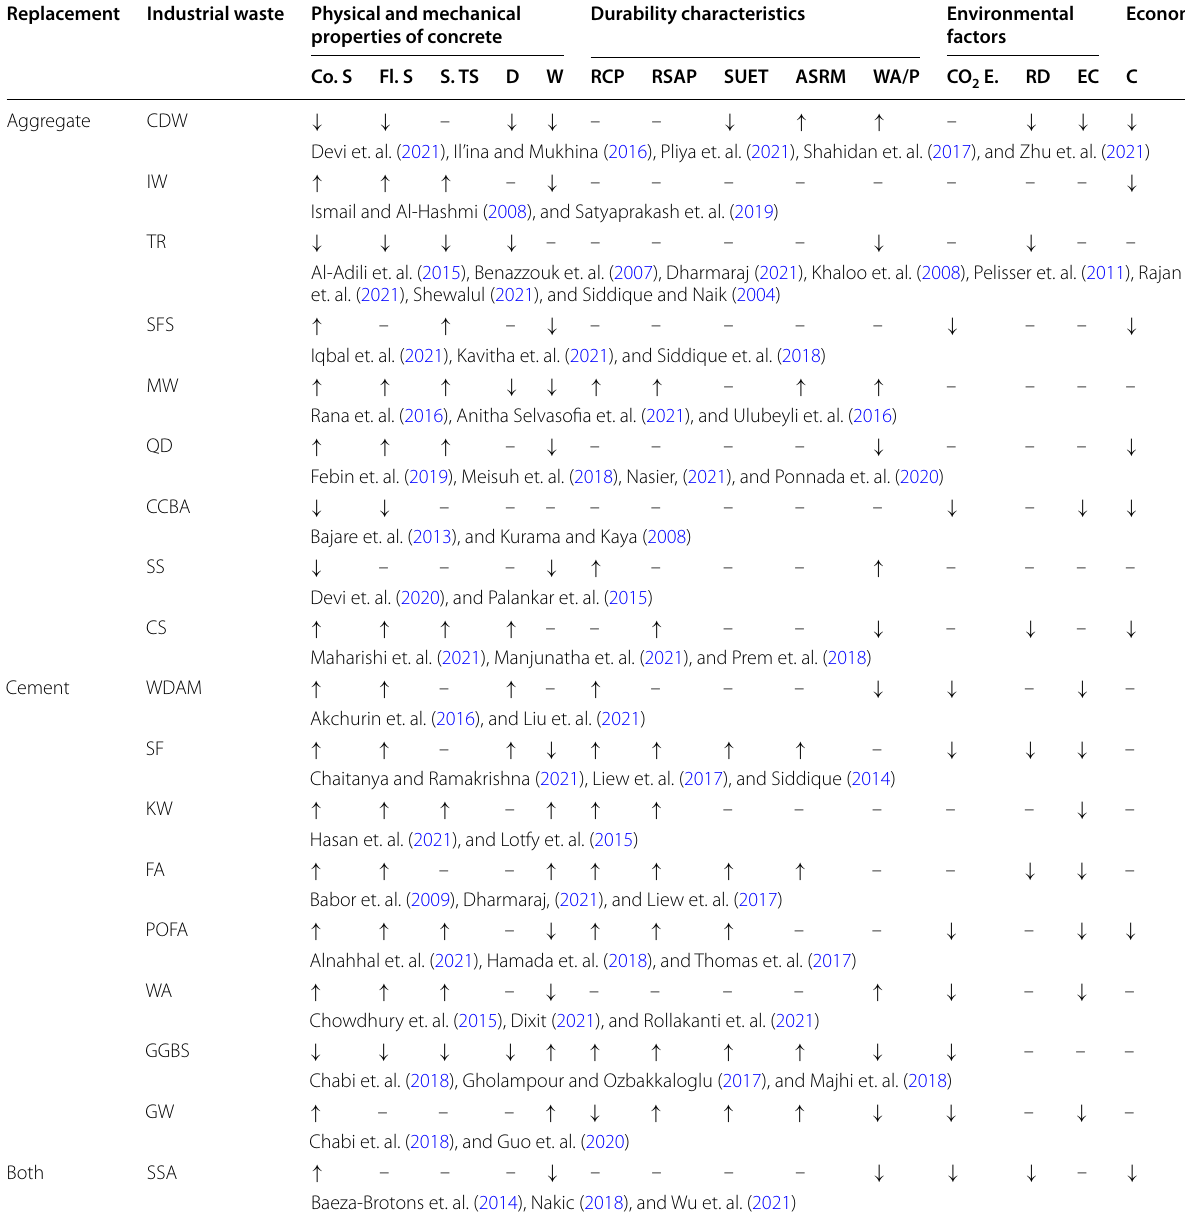
Table 3 Database for the effect of industrial wastes on the concrete